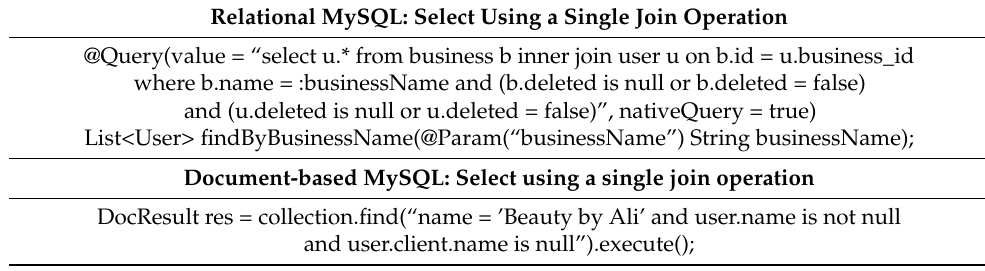
Table 9. Select operation using a single join. Relational MySQL: Select Using a Single Join Operation